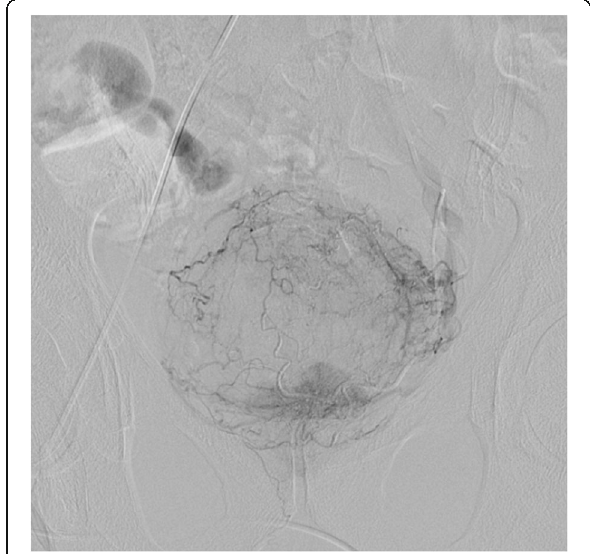
Fig. 1 Neovascularization in projection of tumor bed Fig. 3 Finishing embolization on the right side